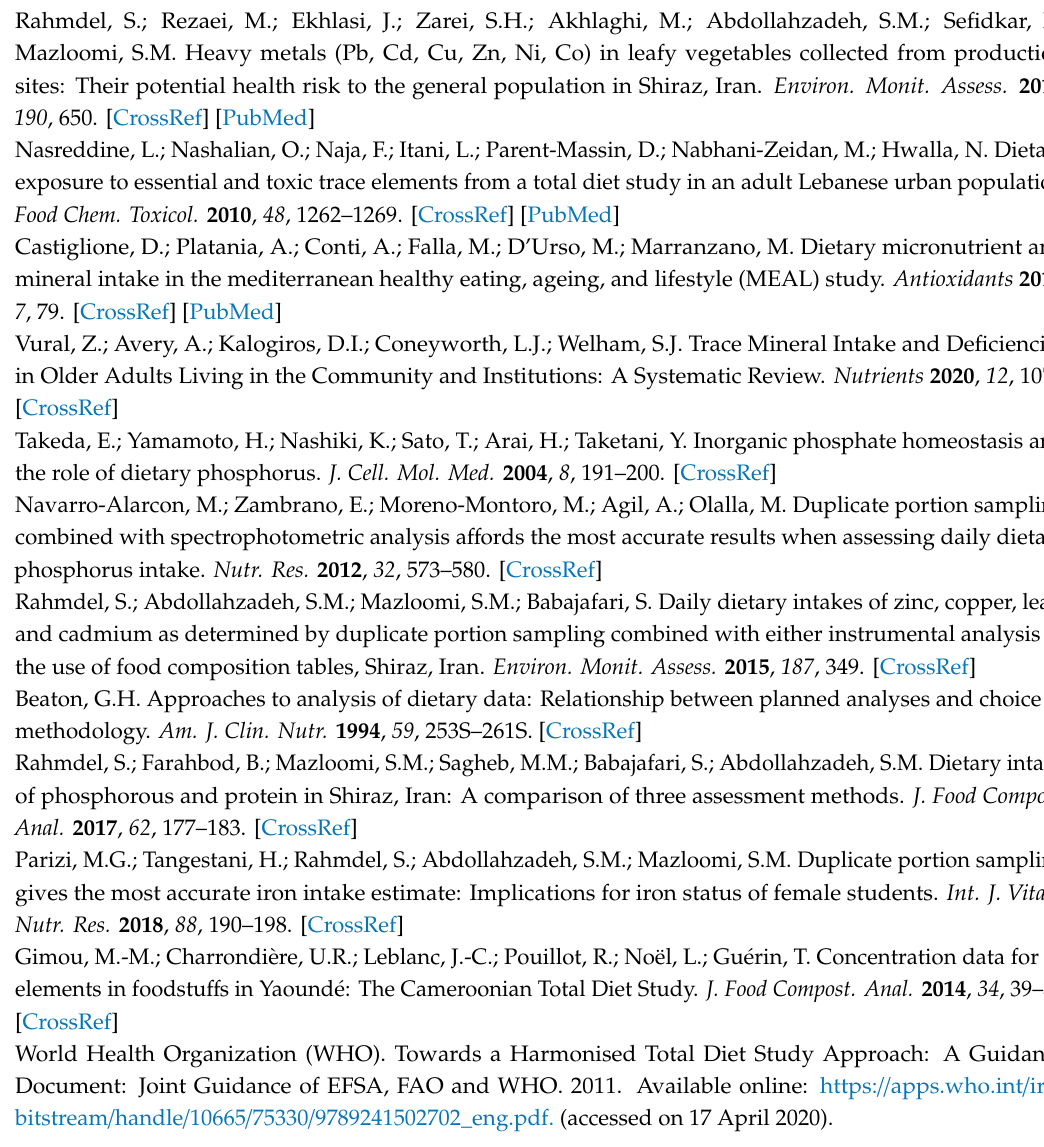
Table S1: The mean concentrations (mg / kg fresh weight) of zinc (Zn), copper (Cu), magnesium (Mg), calcium